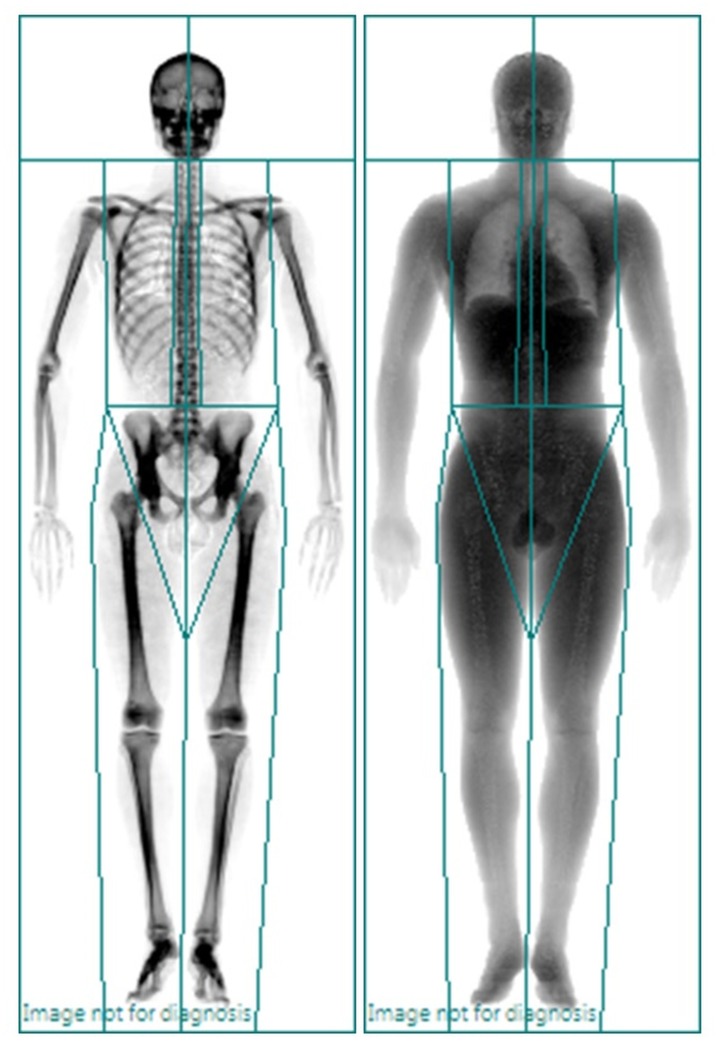
The regions of interest to enable the appropriate cuts according to the manufacturer’s instructions.